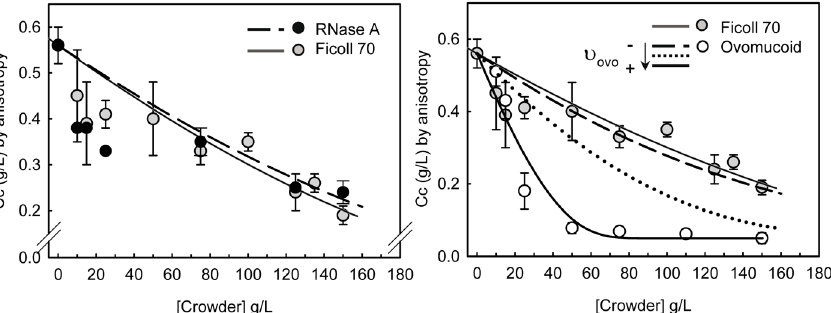
Fig 2. Concentration dependent effect of Ficoll 70, ovomucoid and RNase A on the polymerization of FtsZ. Symbols correspond to the variation of FtsZ Cc with the crowders concentration ± SD, average of at least three independent measurements. Lines correspond to the simulations according to the volume exclusion model detailed in the main text. υ FtsZ = 0.74 mL/g [3], υ Ficoll = 0.96 mL/g, υ RNase = 0.703 mL/g [32] (tetramers). For ovomucoid, υ Ovo = 0.69 mL/g (dashed black, pure volume exclusion behavior), υ Ovo = 1.61 mL/g (dotted black, repulsion with like molecules [36]) and floating the parameter to υ Ovo = 6.6 mL/g (solid black, accounting for additional effects). Arrow in the legend indicates the sense in which the exclusion volume